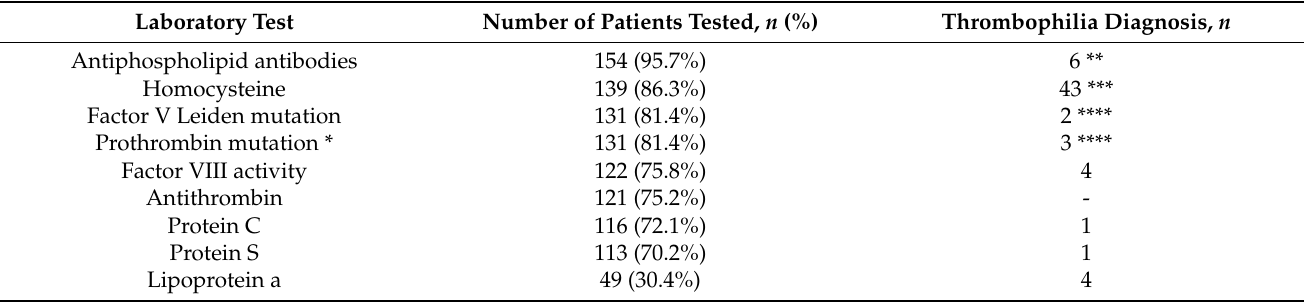
Table 1. Number of laboratory tests performed and thrombophilia diagnosis.